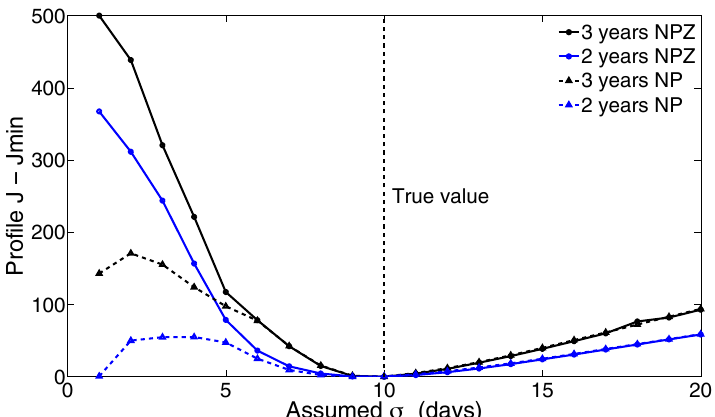
Figure A2. Profiles of the variable lag fit cost function ( − 2 × posterior density) relative to the minimum value for a range of assumed values of the time lag error standard deviation σ τ . For each σ τ , Eq. (A3) was minimized over ( θ , τ , σ log N,P,Z ) for the same data set. Different curves correspond to different scenarios for the number of sampled years (at weekly sampling frequency) and the number of simultaneously sampled variables (black: 3 years; blue: 2 years; solid lines with circles: nutrient–phytoplankton–zooplankton sampling; dashed lines with triangles: nutrient–phytoplankton sampling). The extent to which each curve has a deep minimum close to the true value σ τ (true) = 10 days indicates the feasibility of estimating σ τ for the corresponding sampling